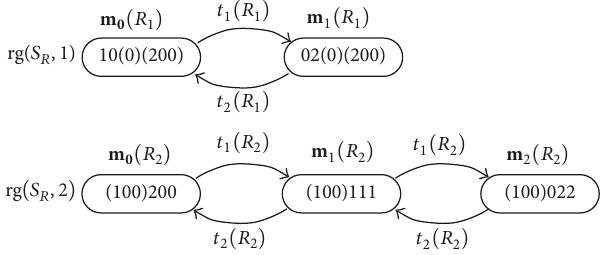
Figure 4: Choice subgraphs of the alternative Petri net 𝑅 1 and 𝑅 2 .